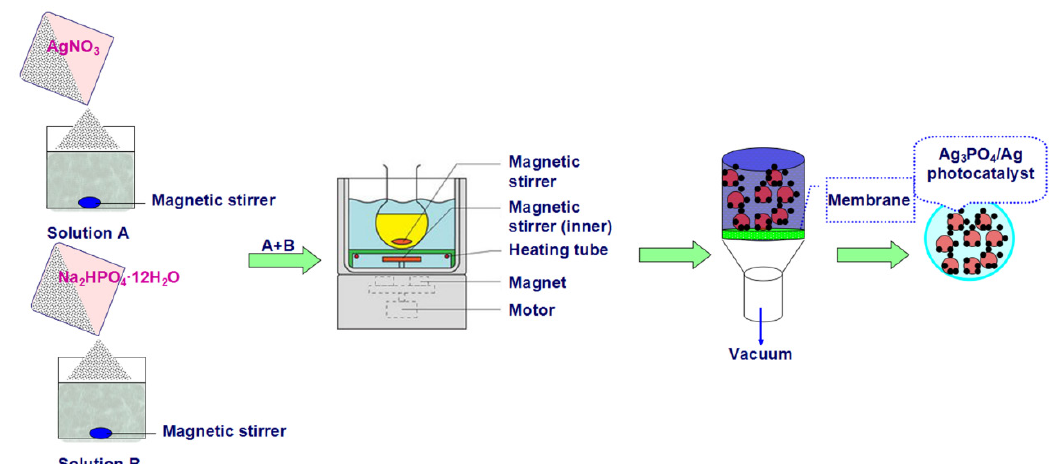
Figure 1. A schematic diagram of the preparation processof Ag